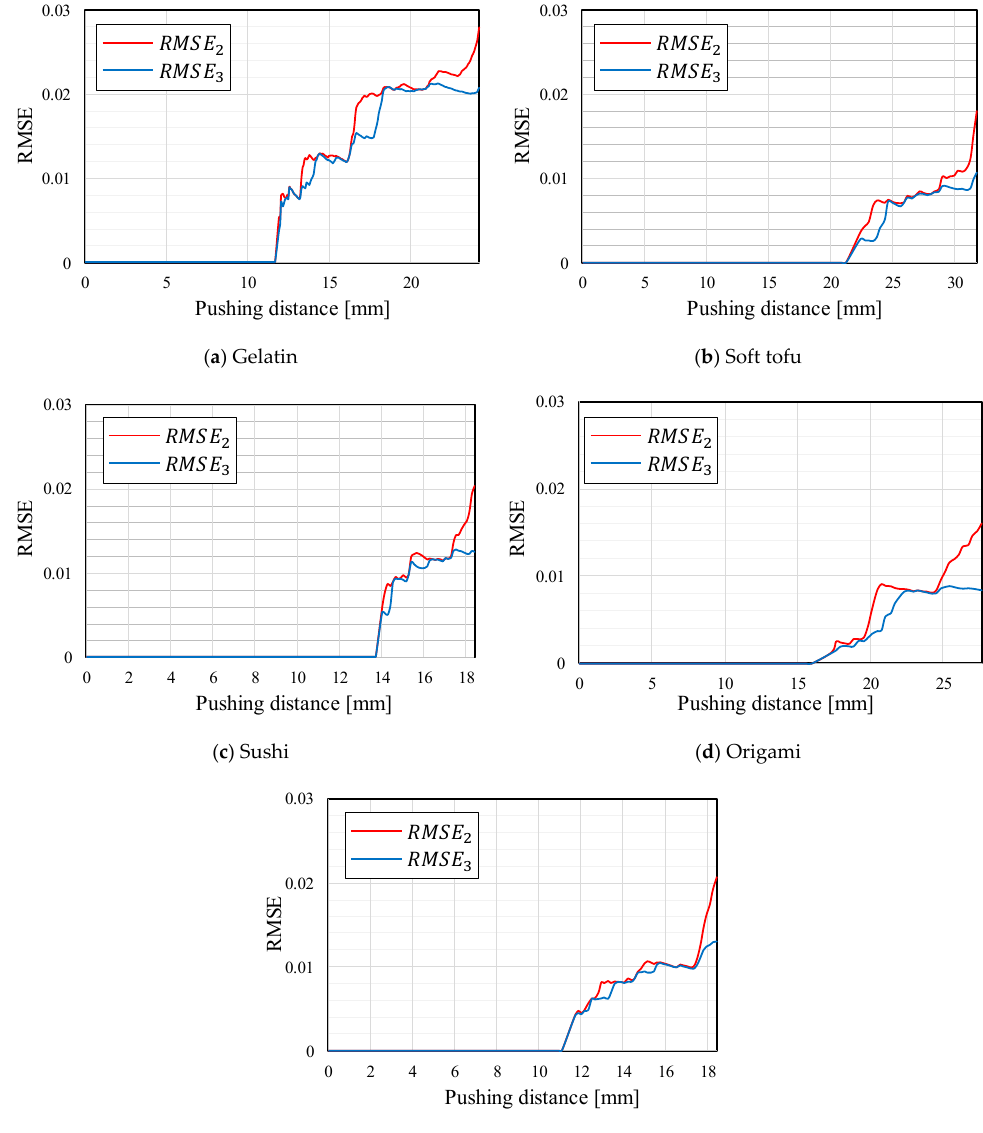
Figure 14. Behaviors of 𝑅𝑀𝑆𝐸 (cid:2870) and 𝑅𝑀𝑆𝐸 (cid:2871) in the grasping test for each target object